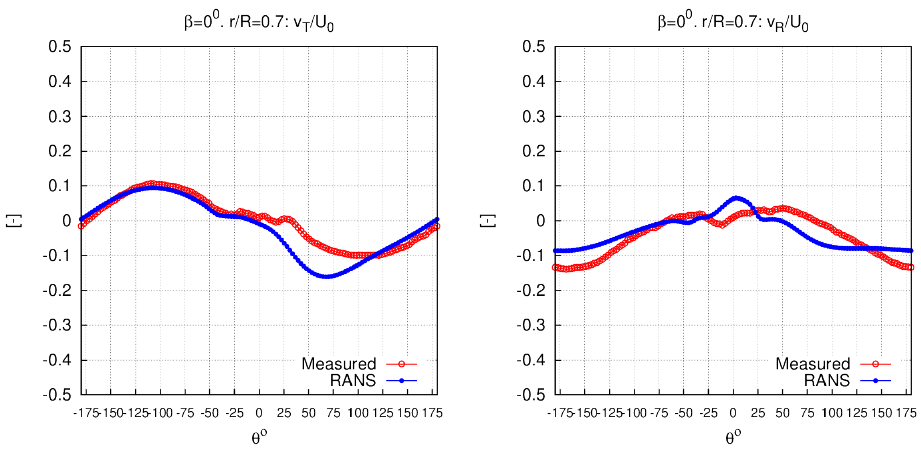
Figure 6. Nominal wake of the model hull in straight-ahead motion: tangential ( left ) and radial ( right ) velocity components by PIV (red plots) and RANS (blue plots) at r / R = 0.70 radial section.